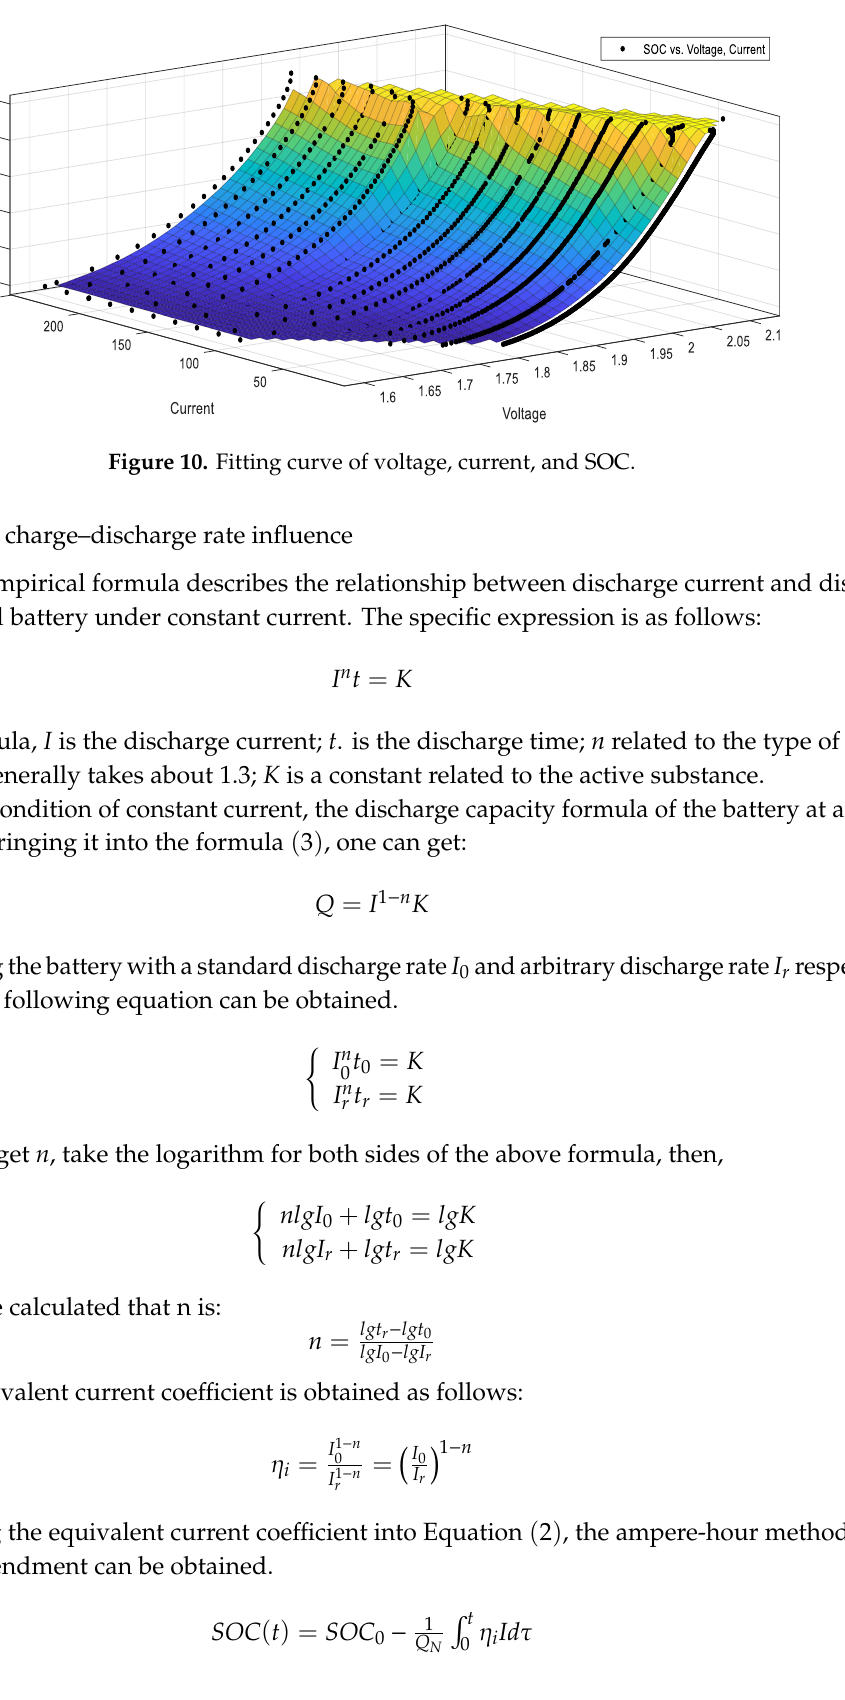
Figure 9. The flow chart of GPRS data sending and receiving software.